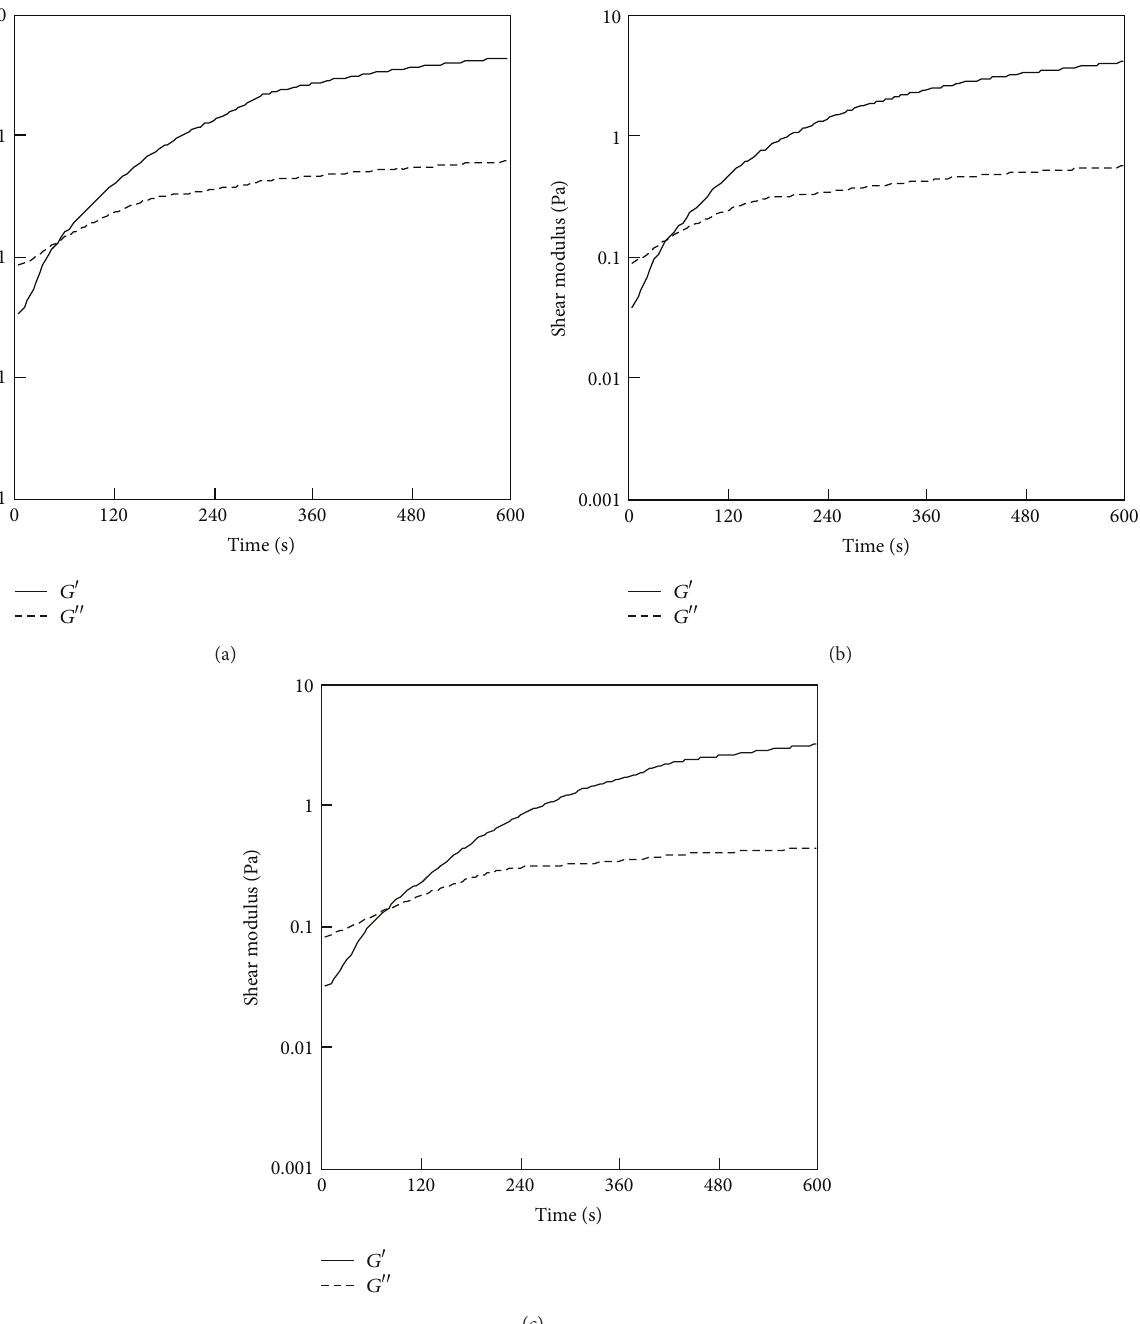
Figure 3: Results of a fluidity test for the 0.5% ASC/genipin solutions containing various concentrations of genipin: (a) 0mM, (b) 0.5mM, (c) 1mM, or (d) 2 mM. Temperatures were maintained at 25 ∘